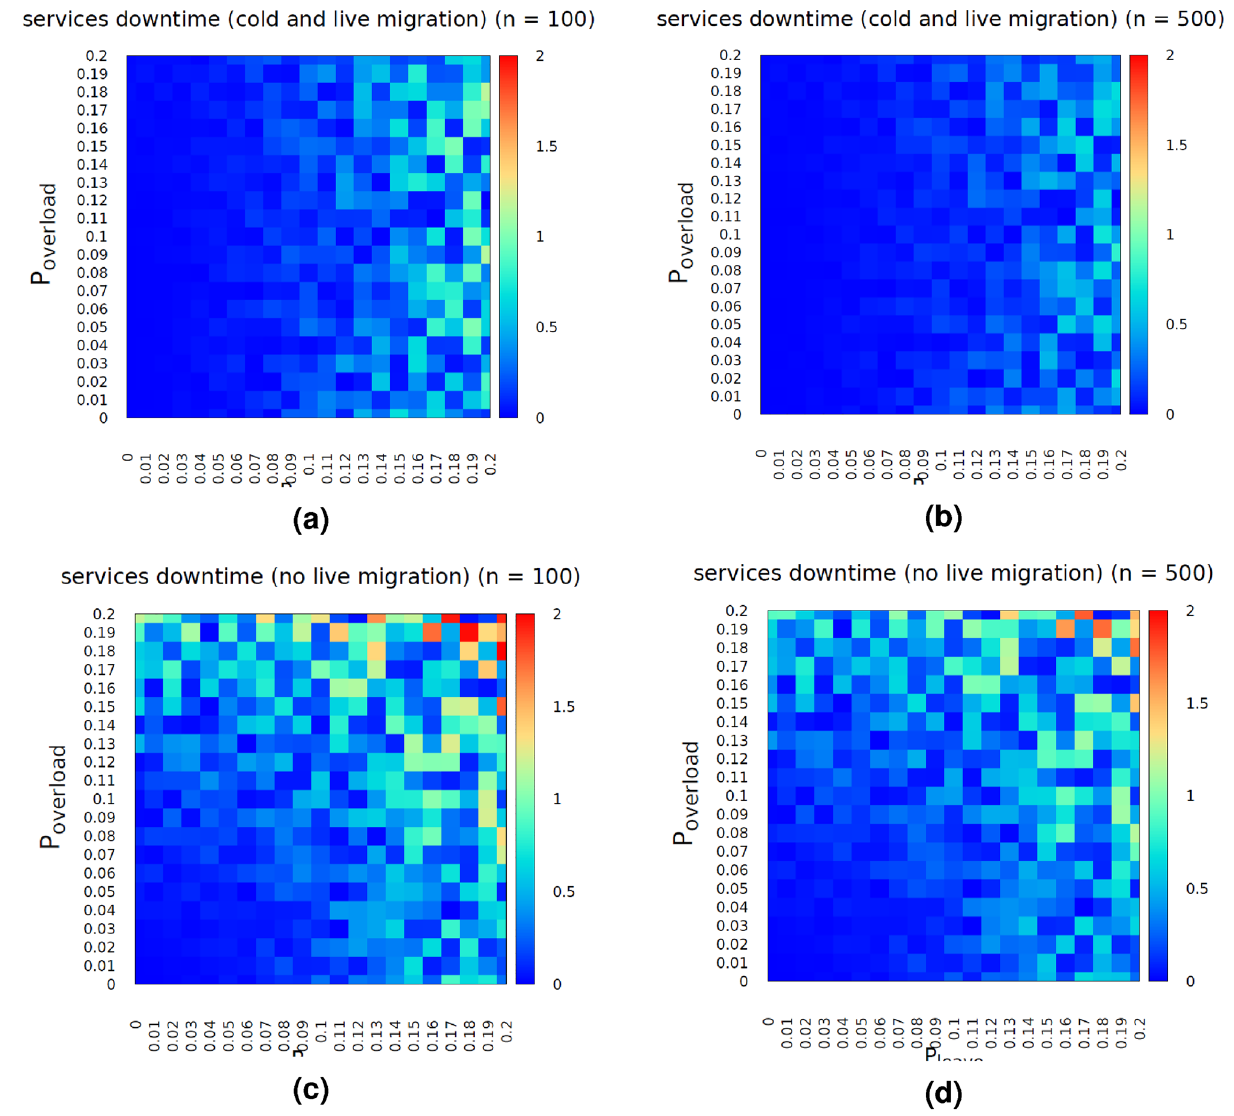
Figure 6. Services’ downtime (%) with ( a, b ) and without ( c, d ) the deployment of overload prediction model for n = 100 ( a, c ) and n = 500 ( b, d